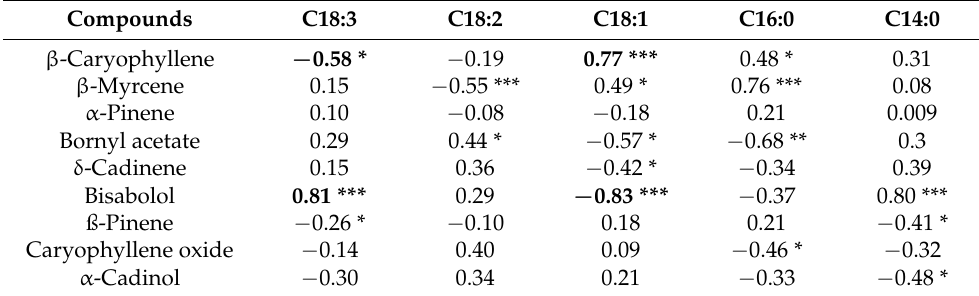
Table 5. Correlation coefficients between major components of EOs and FAMEs from the leaves of Pistacia lentiscus . Compounds